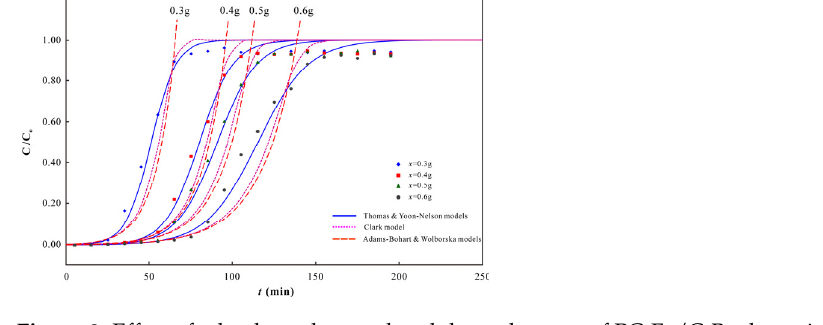
Figure 8. Effect of adsorbent dose on breakthrough curve of PC ‐ Fe/C ‐ B adsorption As(V).